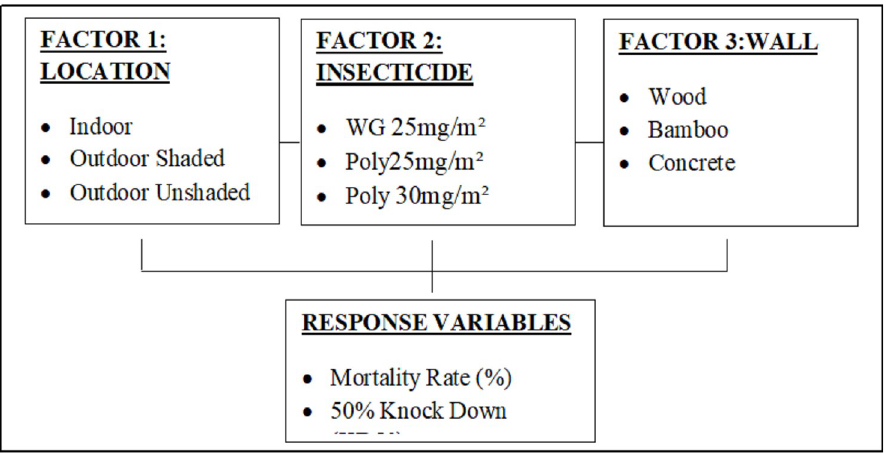
Fig 2. Experimental framework